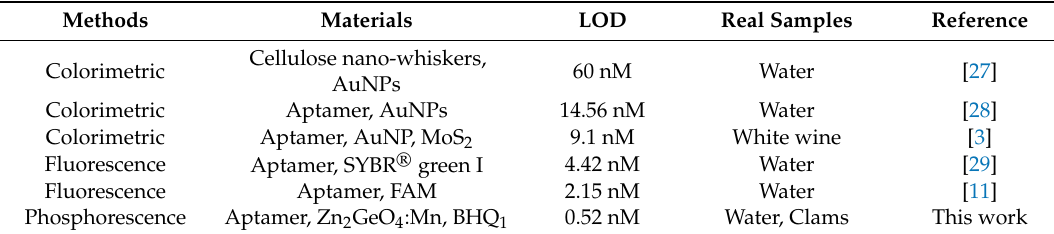
Table 2. Comparison of the method for Cd 2 + detection.